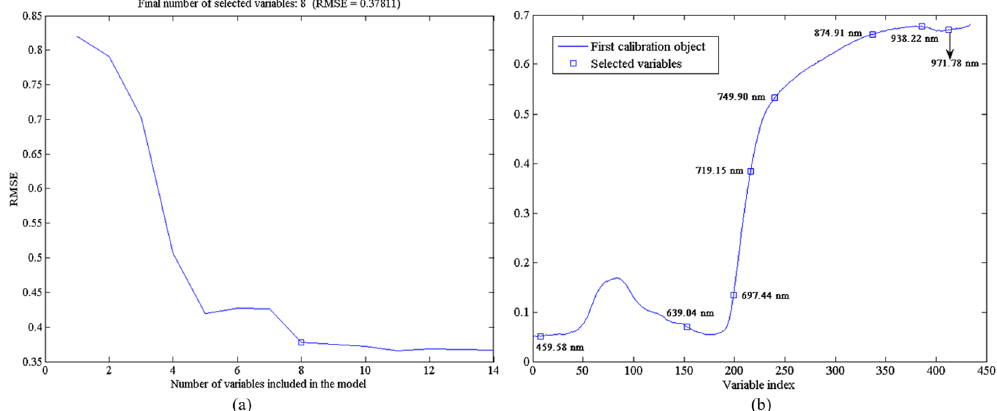
Figure 2. Selection of effective wavelengths by SPA: ( a ) final number of selected variables according to the minimum root mean square error of validation (RMSEV) in the validation set of multiple linear regression (MLR) calibration; ( b ) effective wavelengths shown in circle